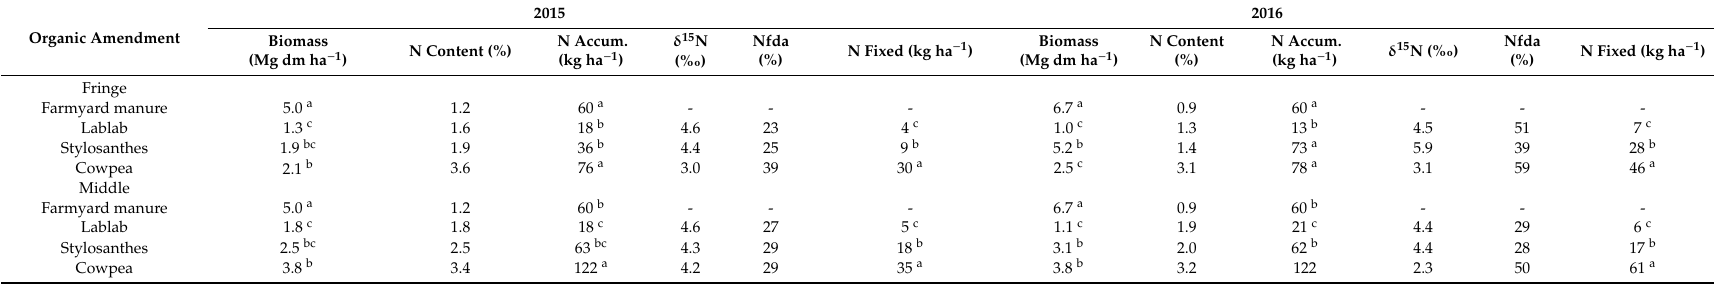
Table 2. Characterization of the organic amendments (biomass and N accumulation and the shares and amounts of N 2 fixed by legumes) applied at the fringe and the middle positions of Kilombero floodplain in 2016 and